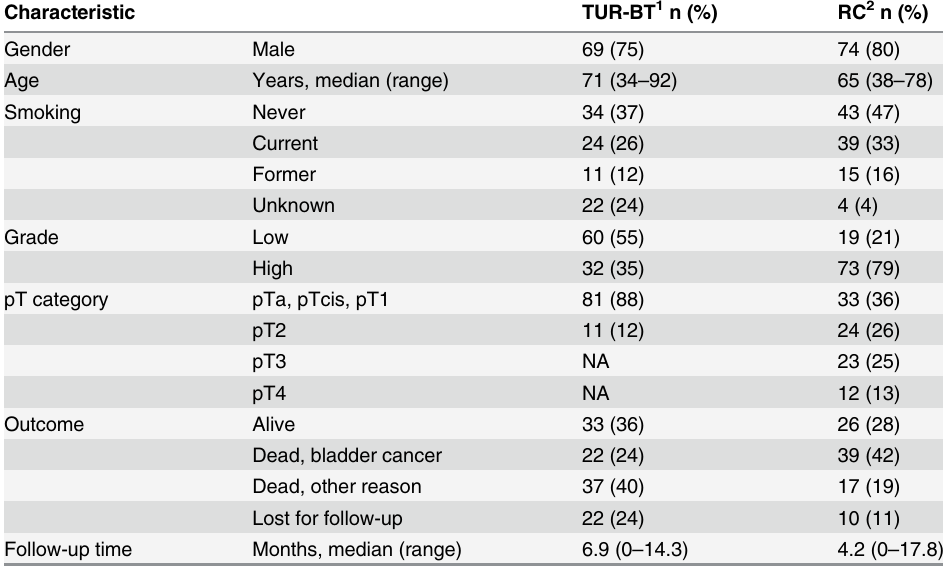
Table 1. Baseline clinicopathological characteristics (n =